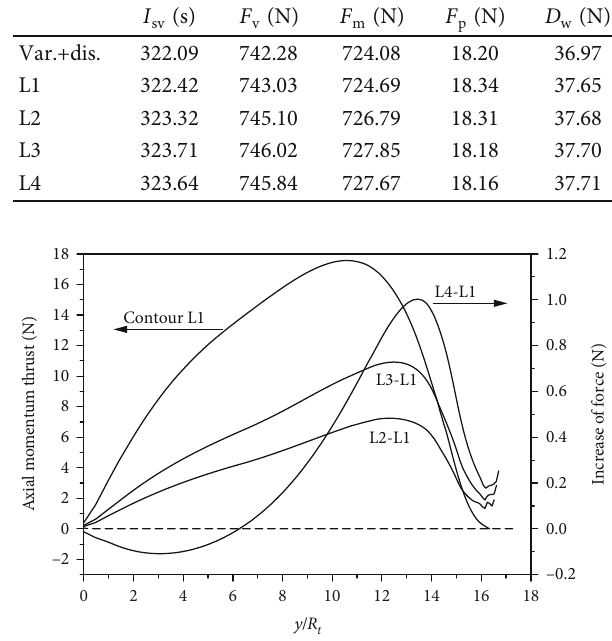
Table 4: Performance of the nozzle designed by di ff erent methods. Mass fl ow